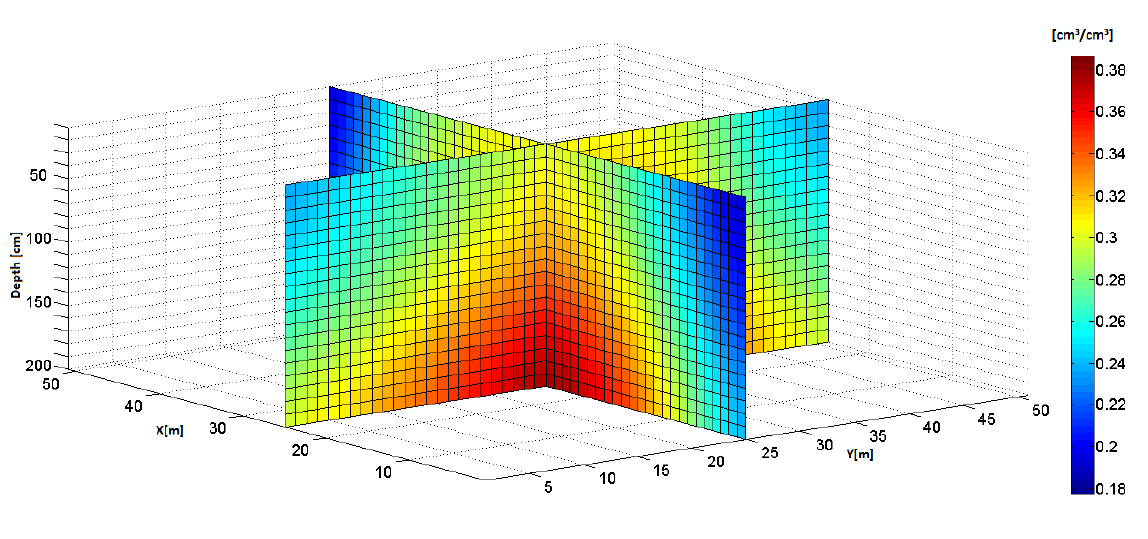
Figure 6. Water content section in silt soil textures.